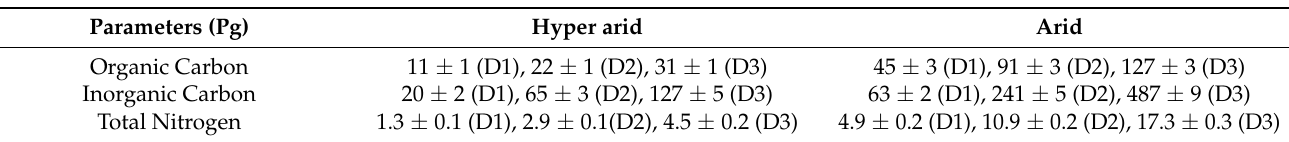
Table 3. Elemental stocks (mean ± standard deviation) of the global hyper arid and arid soils in three different soil depths; modified from